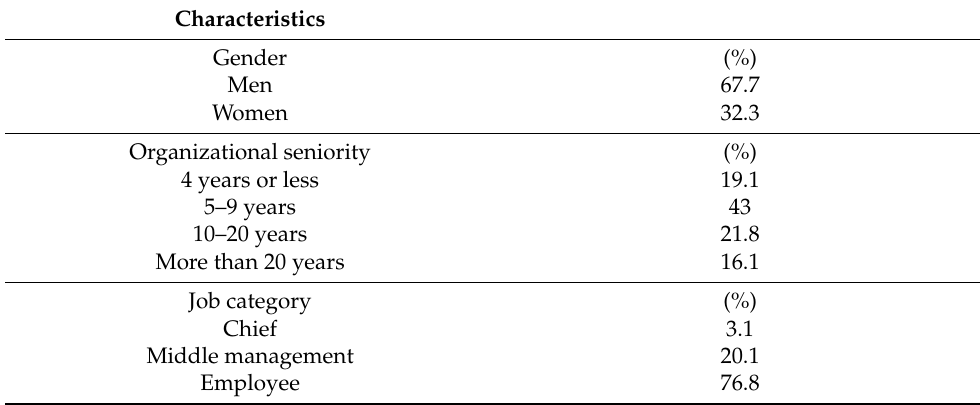
Table 2. Socio-demographic characteristics of the sample (Study 2, N =